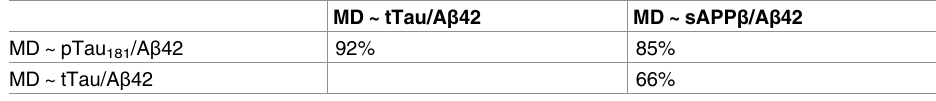
Table 10. The percent overlap between the significant finding maps using the DTI MD.